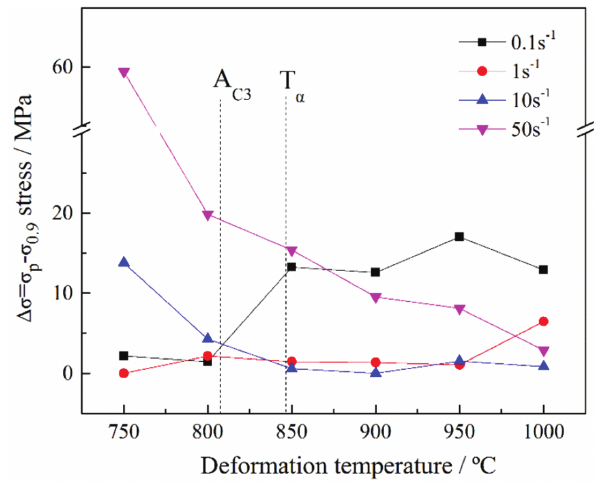
Figure 4: Flow softening of 49MnVS3 non-quenched and tempered steel with increasing temperature for various strain rates.